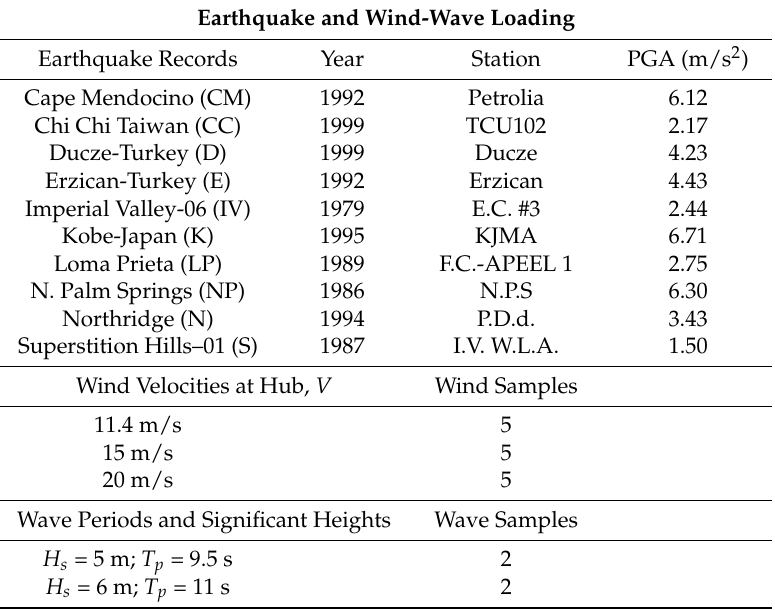
Table 3. Earthquake records, wind velocities at the hub and sea states (PGA = peak ground